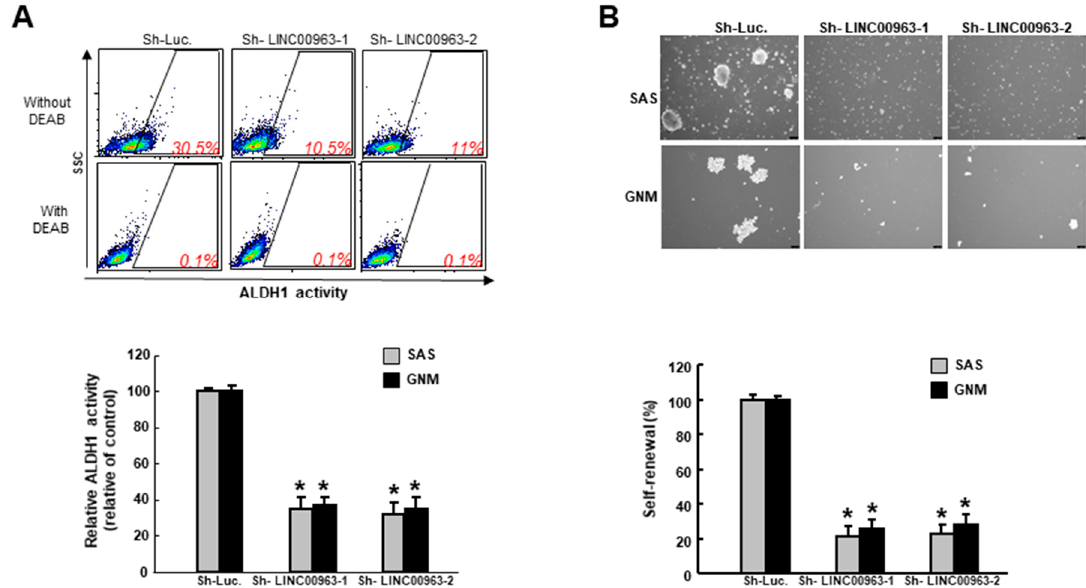
Figure 4. Downregulation of LINC00963 reduces the cancer stem cells (CSC) marker and self-renewal ability in OSCC cells. ( A ) The ALDH1 expression was analyzed by flow cytometry and ( B ) self-renewal capacity was assessed by serial sphere formation assay. * p <0.05